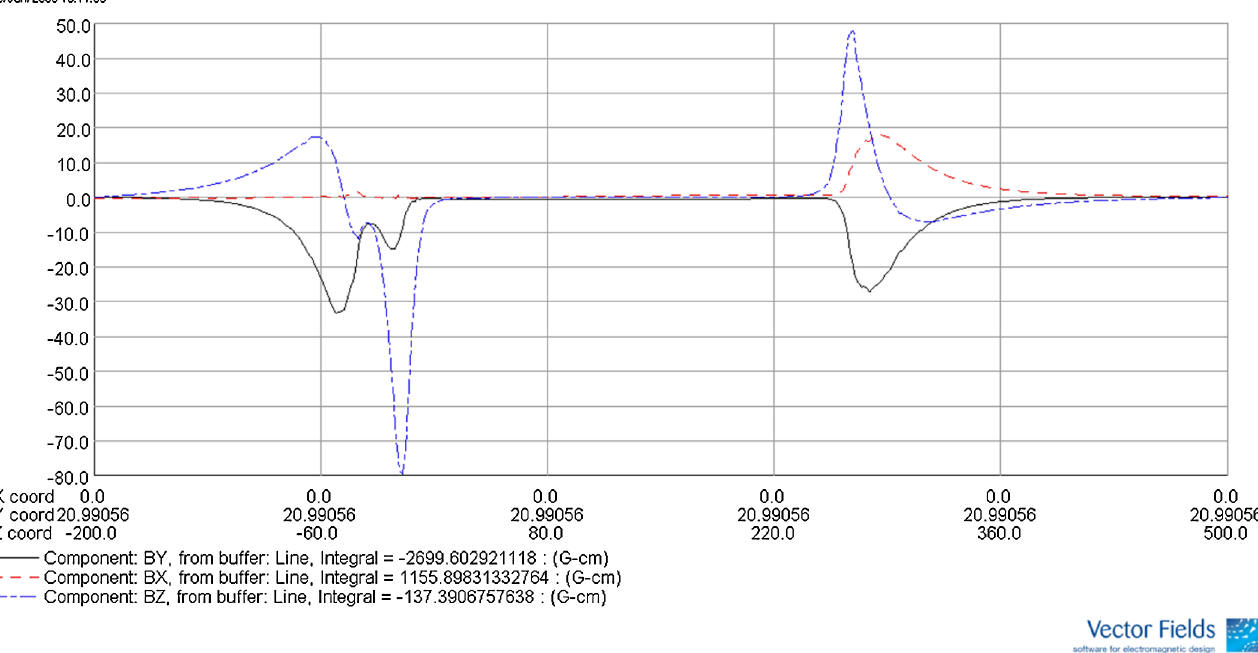
FIG. 5. (Color) Magnetic field distribution on circulating beam axis.